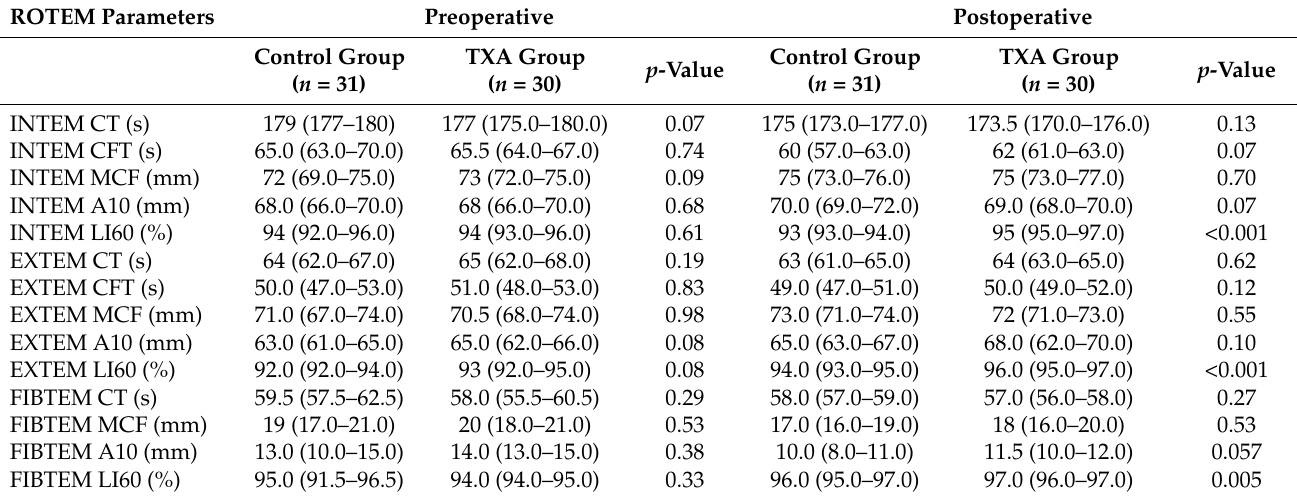
Table 4. Preoperative and postoperative ROTEM parameters of the two groups.